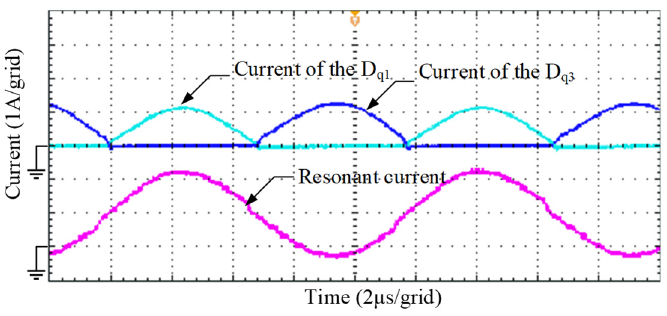
Figure 36. Output current.